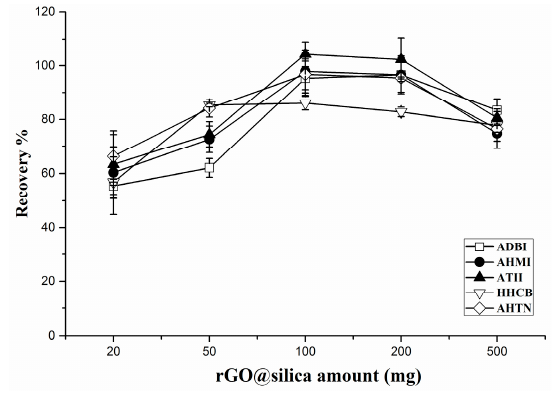
Figure 3. Effect of rGO@silica amount on SPE efficiency.